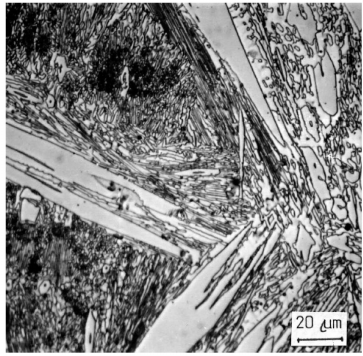
Figure 11. Detail of massive carbidic particles E 518